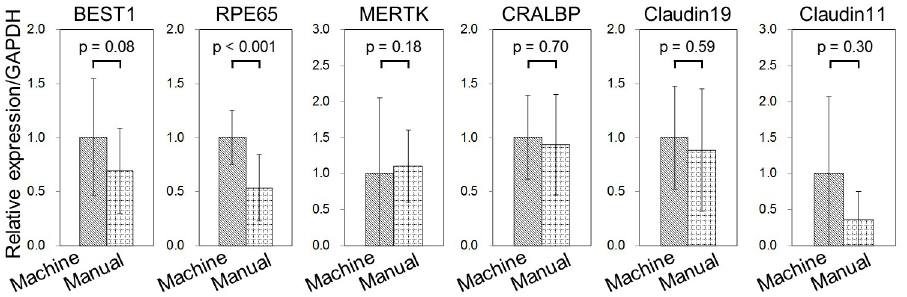
Fig 3. Real-time PCR analysis of RPE-related gene expression in hiPS-RPE cell sheets. Data were obtained from two independent experiments. Machine cell culture, n = 7, manual cell culture, n = 5. All data are represented as the means ± SD.